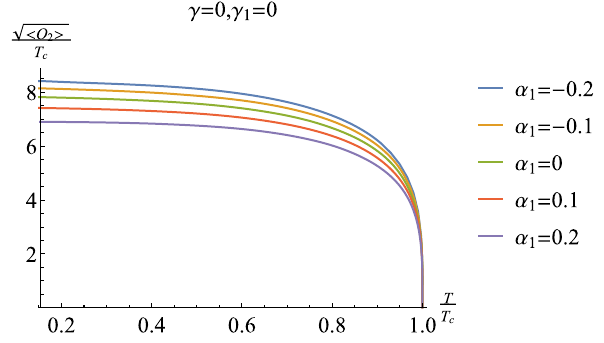
Fig. 8 The condensation T / T c for different α 1 . Here the mass of scalar field is m 2 = − 2 (cid:15) ∇ ν X μνρσ F ρσ